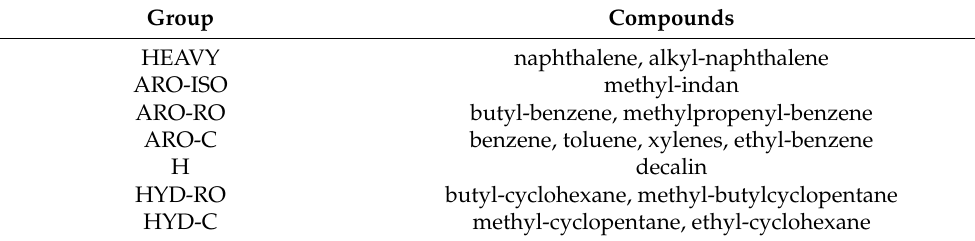
Table 6. Compounds assembled in different groups.